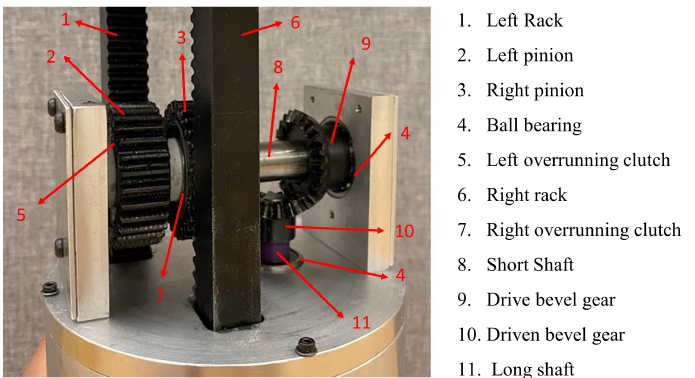
Figure 2. Schematic representation of the suspension transmission elements.